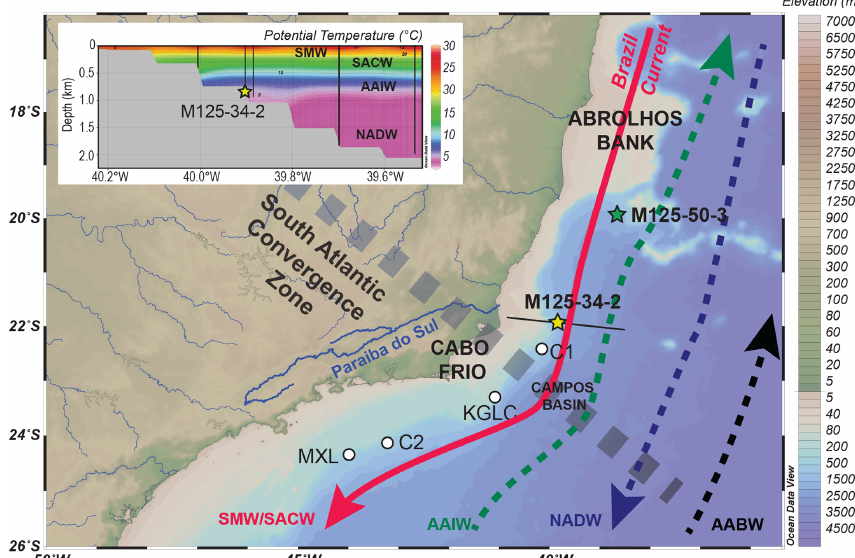
Figure 1. Location of core M125-34-2 (yellow star) on Bowie Mound, reference core M125-50-3 (green star) and other CWC records published in Mangini et al. (2010) and Ruckelshausen (2013; white dots). Major surface- (red line), intermediate- (green), and deep-water circulation features (blue) and water masses are indicated as well as the approximate location of the South Atlantic Convergence Zone (stippled line) as the main atmospheric feature. The inset shows a hydrographic section crossing the location of Bowie Mound core M125- 34-2 with potential temperatures as measured via CTD (black lines) during R/V METEOR expedition M125 (Bahr et al., 2016; Raddatz et al., 2020); the location of the hydrographic section is indicated by a black line on the map. Figure modified after Raddatz et al. (2020). AABW: Antarctic Bottom Water; AAIW: Antarctic Intermediate Water; NADW: North Atlantic Deep Water; SACW: South Atlantic Central Water; SMW: Salinity Maximum